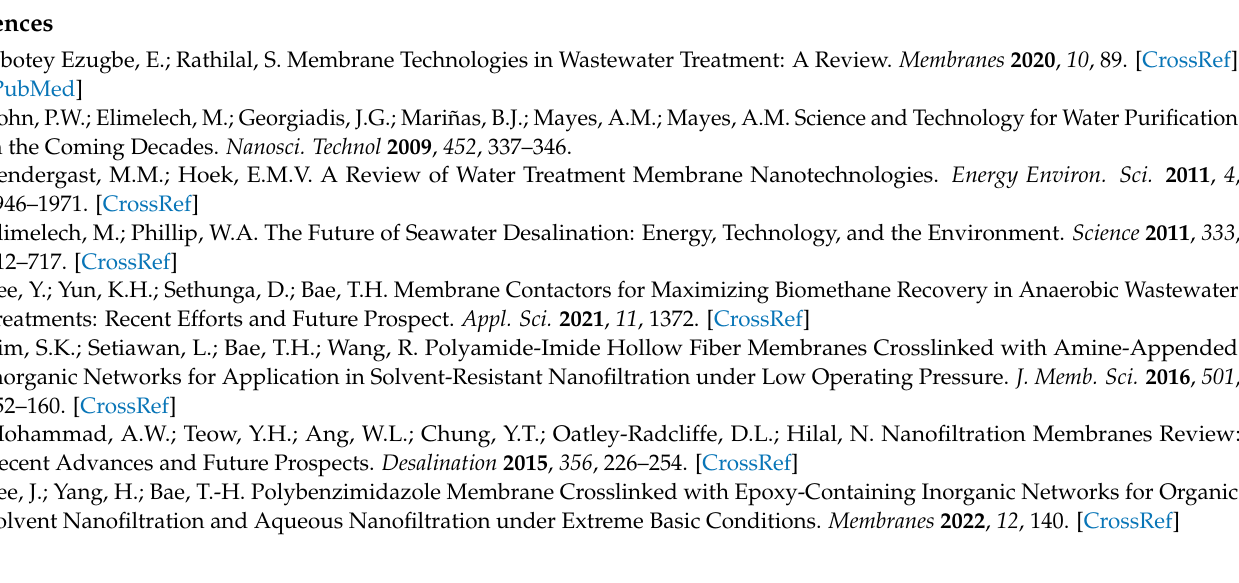
Table S3: Performance comparison of crosslinked GO-based NF membranes for water